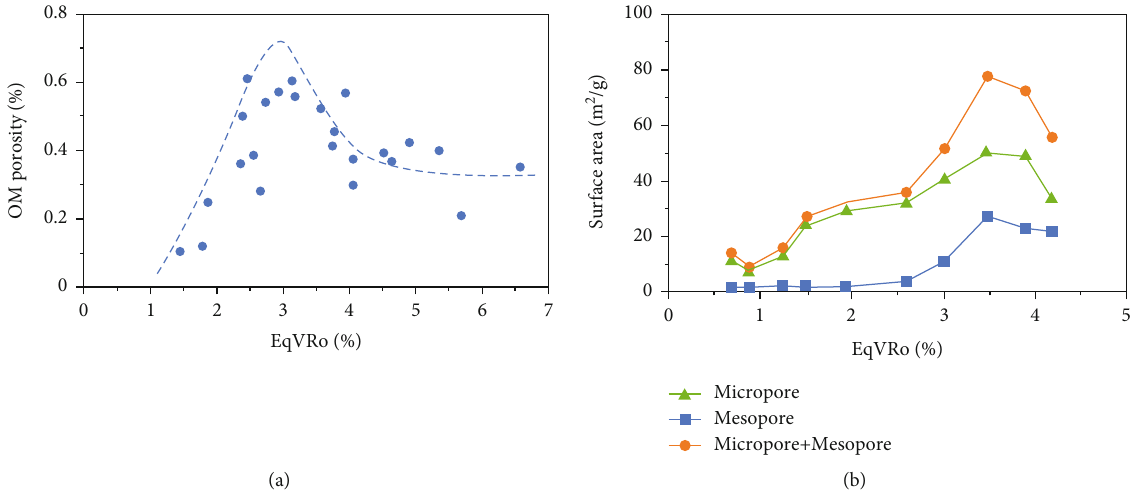
Figure 6: Cross-plots of the EqVRo value versus (a) OM porosity and (b) speci fi c surface area (modi fi ed from Chen and Xiao [139]; Xu et al.